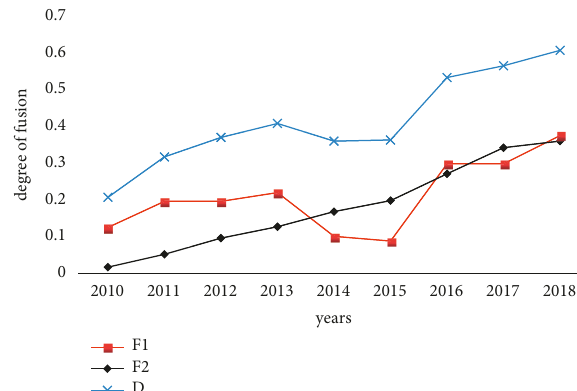
Figure 10: Trend chart of the integrated development level of cultural industry and tourism industry from 2010 to